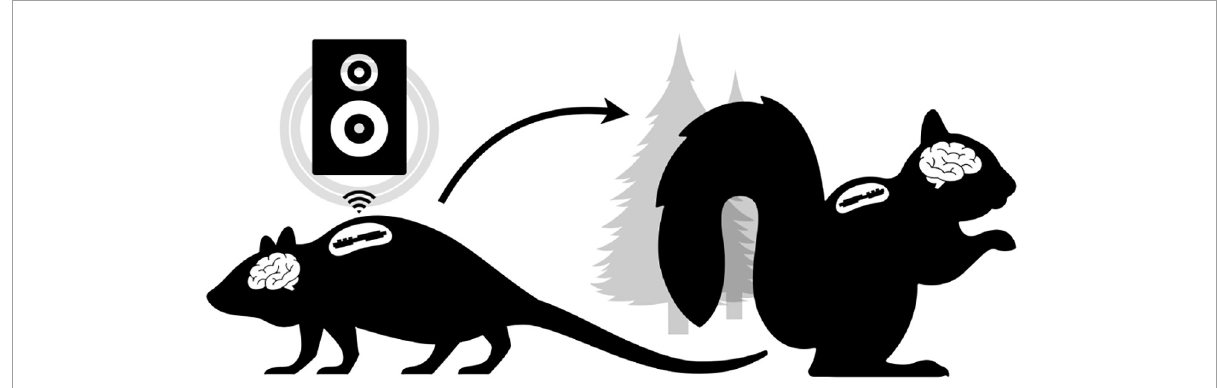
FIGURE1 Conceptual Overview. The laboratory setting (left) does not have tools to enable freely behaving neurophysiology in novel experimental paradigms (e.g., low-latency wireless cuing of an external speaker to modulate neural rhythms in real-time). Ideally, the same “biologger” platform can translate to ethical free-ranging experiments (right) utilizing alternative device modes that support autonomous